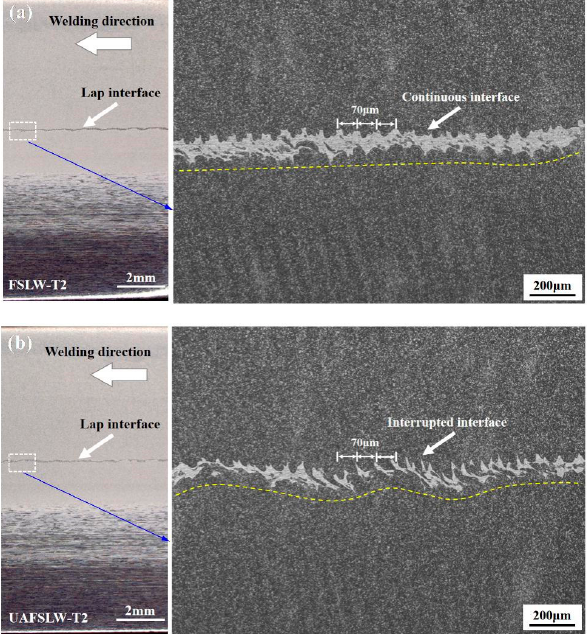
Figure 6. Longitudinal cross section (C 0 –C 1 ) of lap joints produced by tool T2: ( a ) FSLW joint and ( b ) UAFSLW joint.